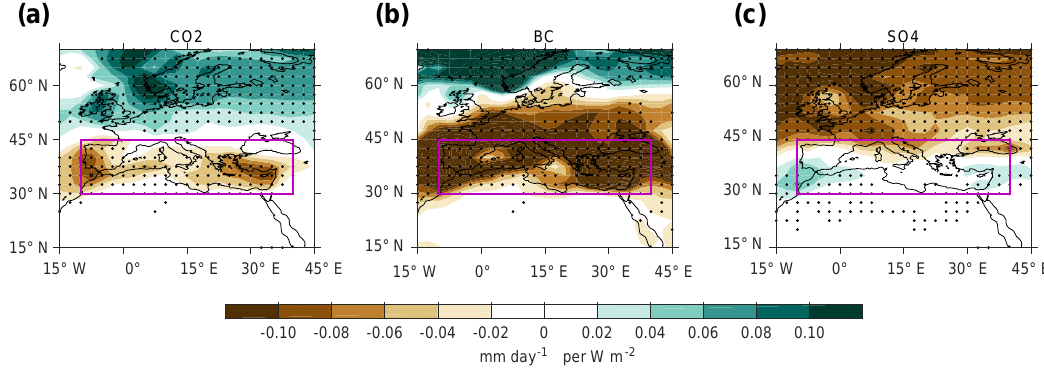
Figure 1. Normalized (cid:49)P (change per unit forcing) for (a) CO 2 , (b) BC and (c) SO 4 . Black dots indicate that the change is significant at 0.95 confidence level. Please note that the sign for SO 4 is flipped due to its negative forcing. Thus, the result shown for SO 4 is the precipitation change per unit negative